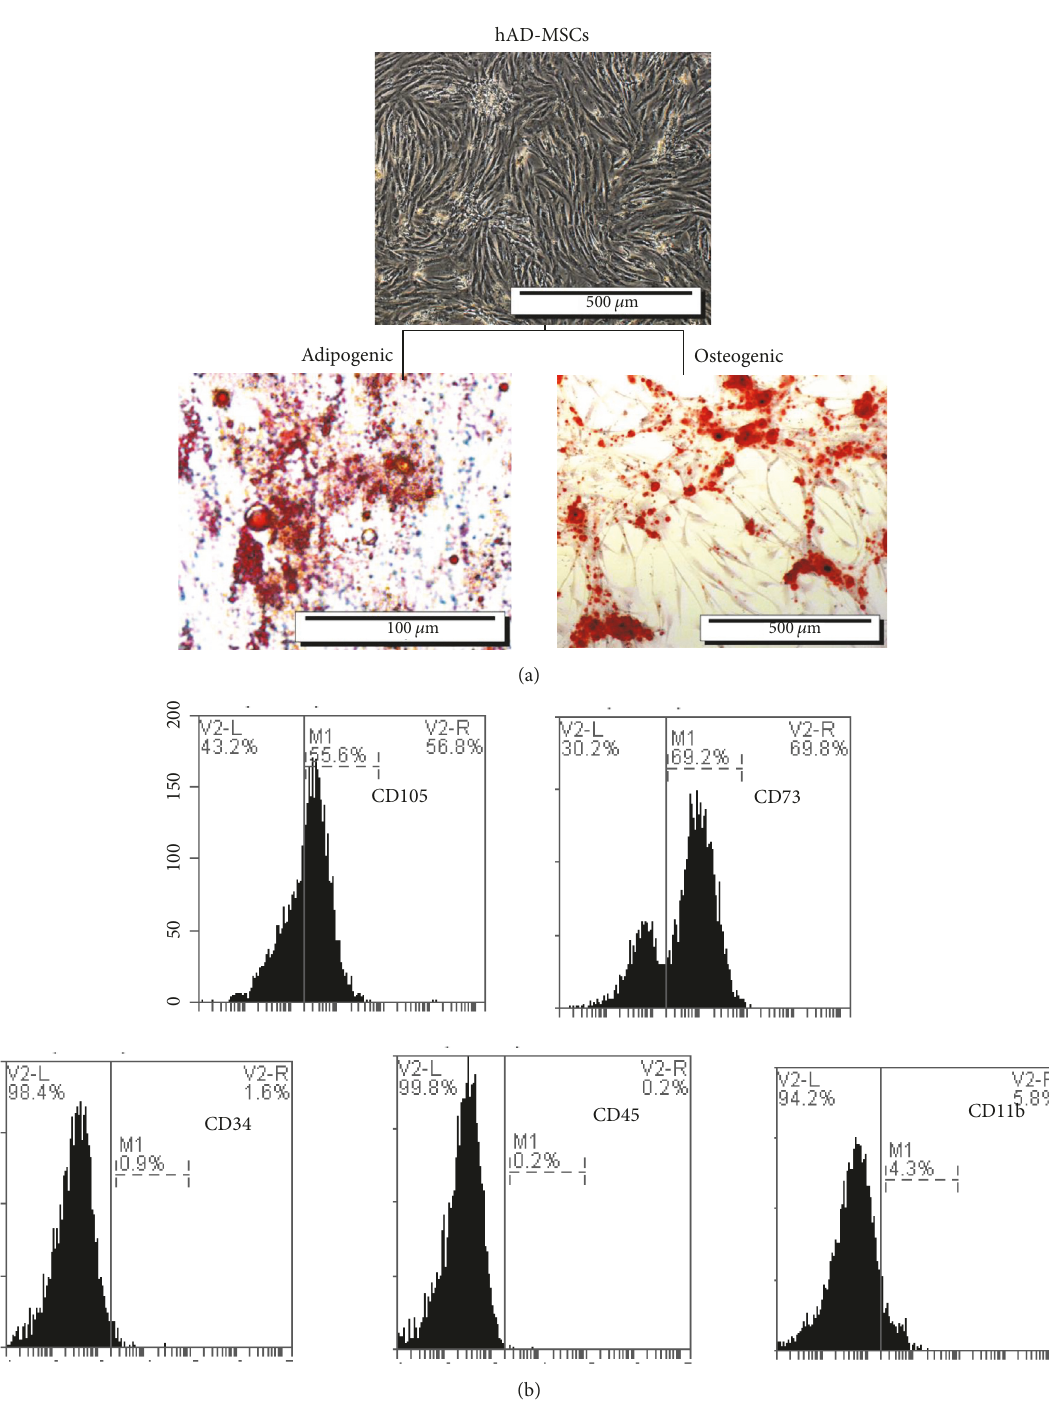
Figure 1: The isolated mesenchymal stem cells (MSCs) characterization by flow cytometry and differentiation. (a) The second passage of isolated hAD- MSCs. Adipogenic: staining of isolated hAD- MSCs after 2nd passage by Oil Red O reagent. Osteogenic: staining of isolated hAD-MSCs by Alizarin Red S reagent. (b) Expression of surface antigens in isolated hAD-MSCs as determined using flow